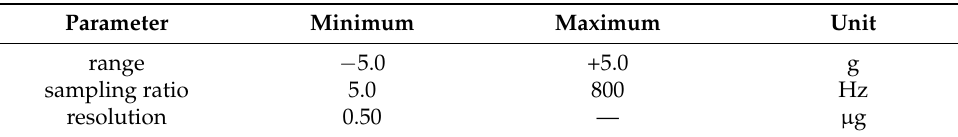
Table 1. The performance indexes of Microchip